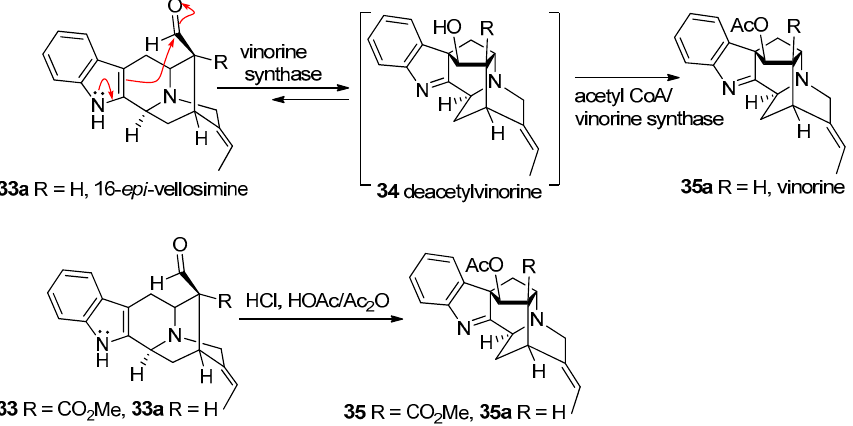
Figure 5. Biosynthetic relationship between sarpagine and ajmaline reported by St ӧ ckigt et al. [62–64].